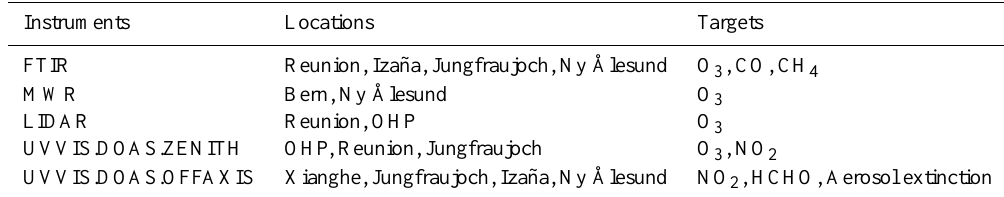
Table 1. List of NORS pilot instruments, stations, and target parameters. UVVIS.DOAS.ZENITH (OFFAXIS) stands for UV–visible (MAX)differential optical absorption spectroscopy (DOAS), FTIR for Fourier transform infrared spectrometer and MWR for microwave